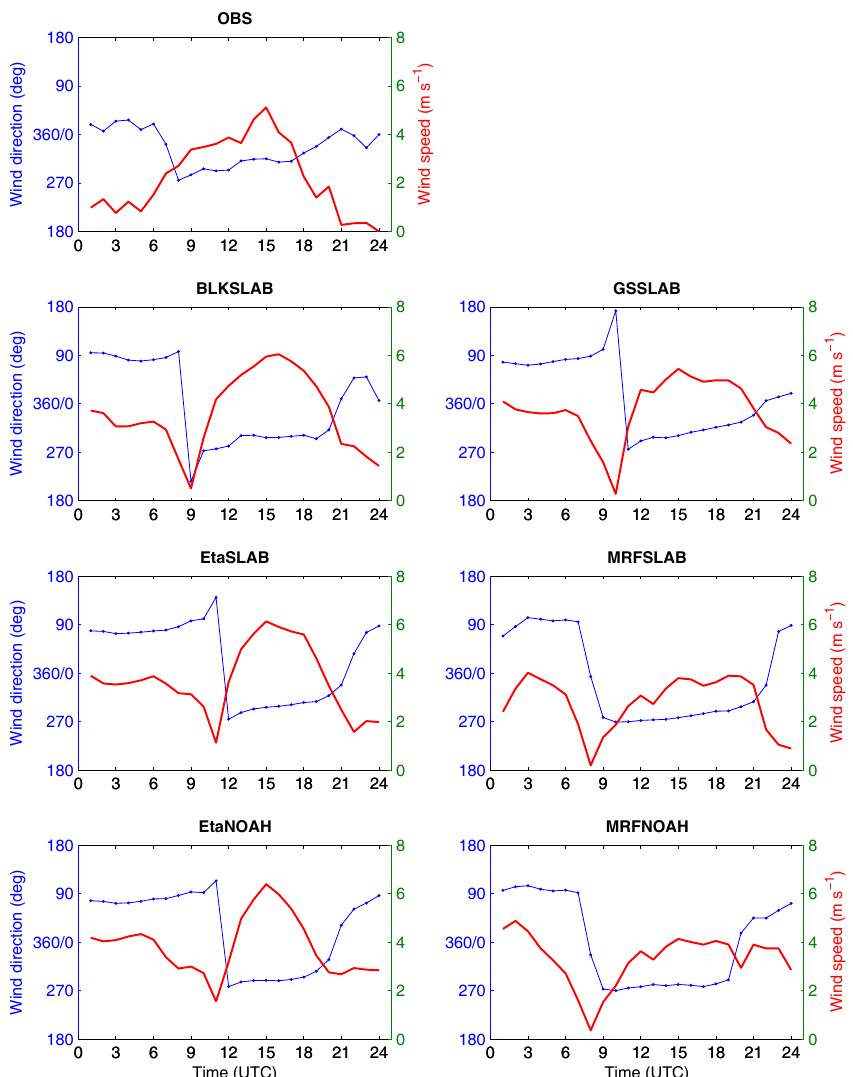
Fig. 2. Observed (OBS) and simulated hourly near-surface wind direction (dotted solid line) and wind speed (solid thick line) with different experiments during the period from 01:00 to 24:00UTC (8 May 2001) at Kanotf¨oreningen site. Observed near-surface wind is measured at height shown in Table 2. Simulated near-surface wind (10m a.g.l.) is from the closest grid point to observational site from D4 with 2-km grid spacing. On 8 May 2001, sunrise time in G¨oteborg (study area) is 03:05UTC, and sunset time is 19:14UTC (http://www.timeanddate. com/worldclock/). LT (local time) = UTC+2 over the study area (D4).